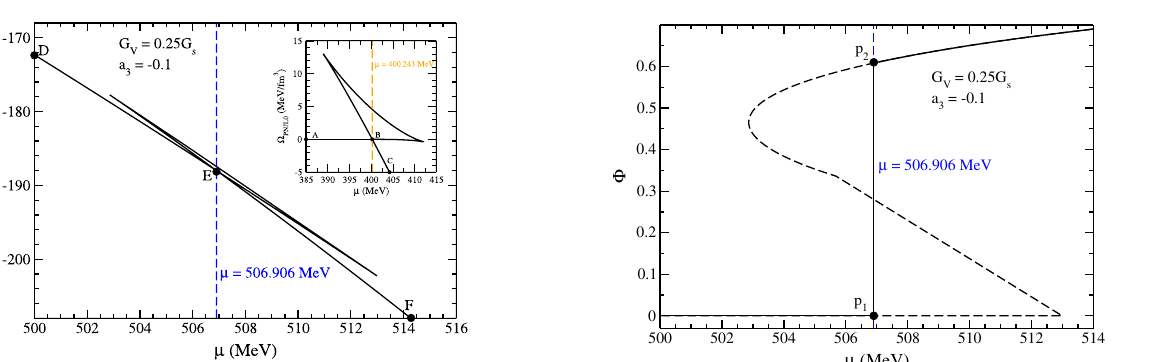
Fig. 5 Φ as a function of μ for the PNJL0 model with G V = 0 . 25 G s and a 3 = − 0 .